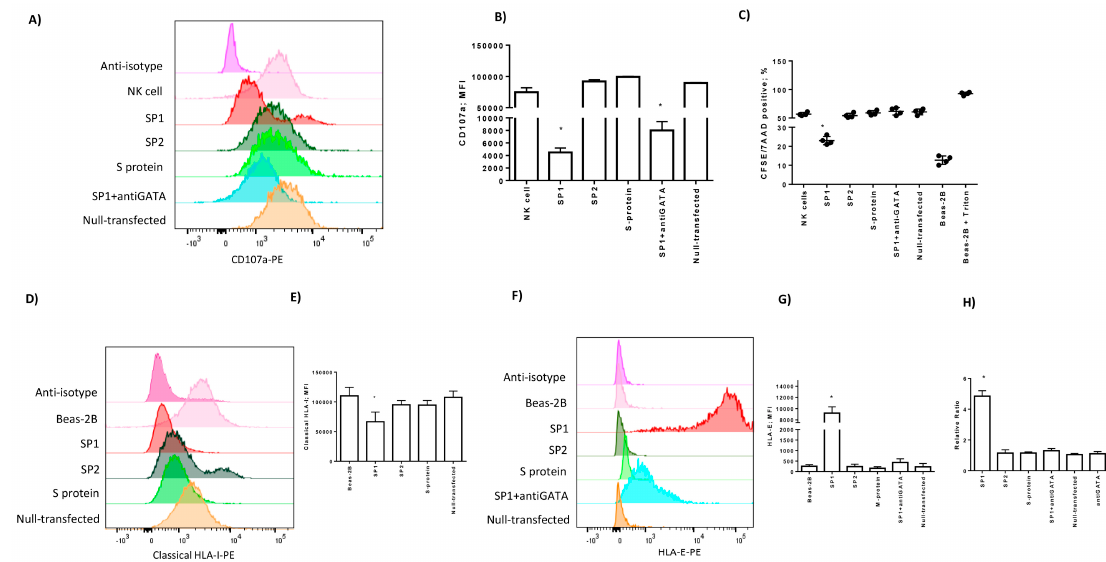
Figure 3. ( A ) Representative histograms of NK cell degranulation towards the Beas-2B cell target. NK cells were marked with CD56 and gated as reported in Figure S1C. The degranulation was assessed by CD107a-PE expression. Beas-2B was transfected with SP1, SP2, and S proteins or control fluorescent antibody was used as the positive control (null-transfected), or treated with GATA3 inhibitor (anti-GATA). ( B ) MFI of CD107a-PE-positive NK cells after the co-culture with Beas-2B cells. ( C ) CFSE +/ 7-AAD + cell percentage in NK cell / Beas-2B co-cultures. Beas-2B alone and treated with Triton-x100 (0.8%) were used as negative and positive controls, respectively. The values are presented as mean ± standard deviation. ( D ) Representative histograms of HLA-I expression on the surface of transfected Beas-2B. ( E ) The histograms showed the mean ± standard deviation MFI (mean fluorescence intensity) values of HLA-I expression in three independent experiments. * significant p values Student t test; ( F ) Representative histograms of HLA-E expression on the surface of transfected Beas-2B cells. ( G ) The histograms showed the mean ± standard deviation MFI (mean fluorescence intensity) values of HLA-E expression in three independent experiments. * significant p values t test. ( H ) Relative ratio of Real-Time PCR of HLA-E expression in transfected Beas-2B cells. SP1 transfected Beas-2B cells were also treated with GATA inhibitor (anti-GATA). * significant p values Student t